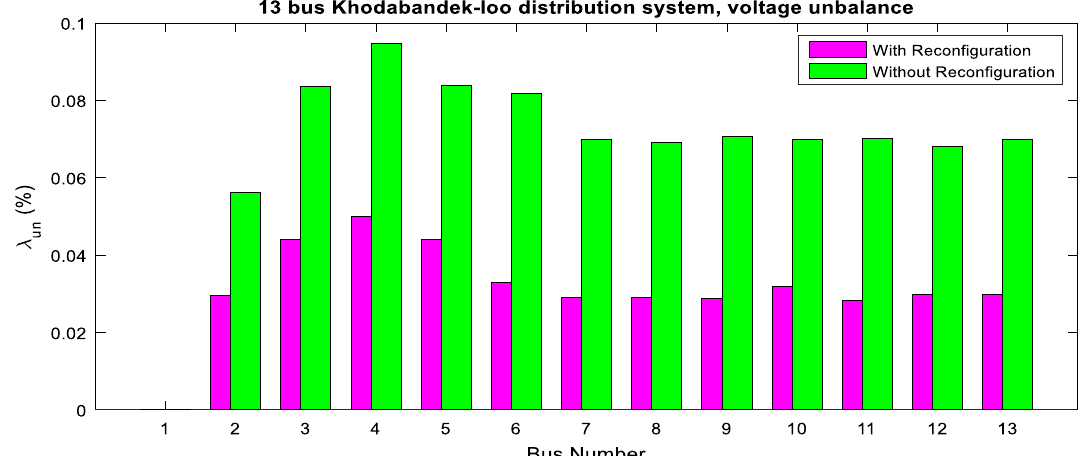
Figure 7. Voltage unbalance of 13-bus network via ITSOA with and without reconfiguration.